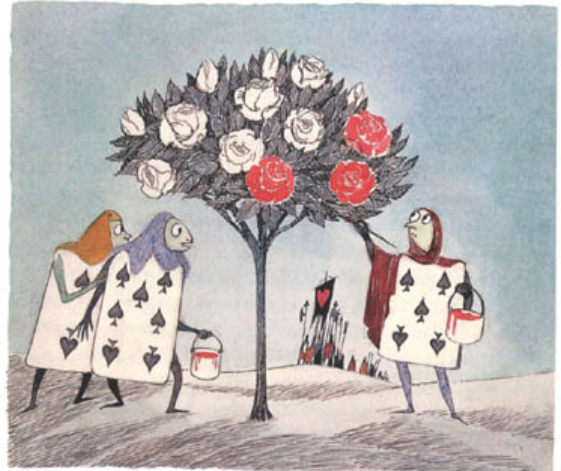
The Queen’s gardeners painting the roses red so she doesn’t chop off their heads. Illustration by Tove Jansson © Moomin Characters (reproduced with